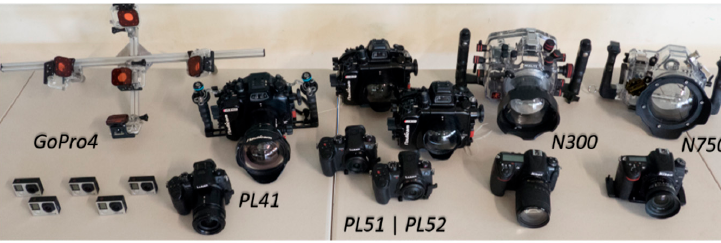
Figure 5. Orthographic view of one of our 5 × 5 m fore reef plots with primary (red) and secondary (blue) reference points, testing site for the five different camera systems.